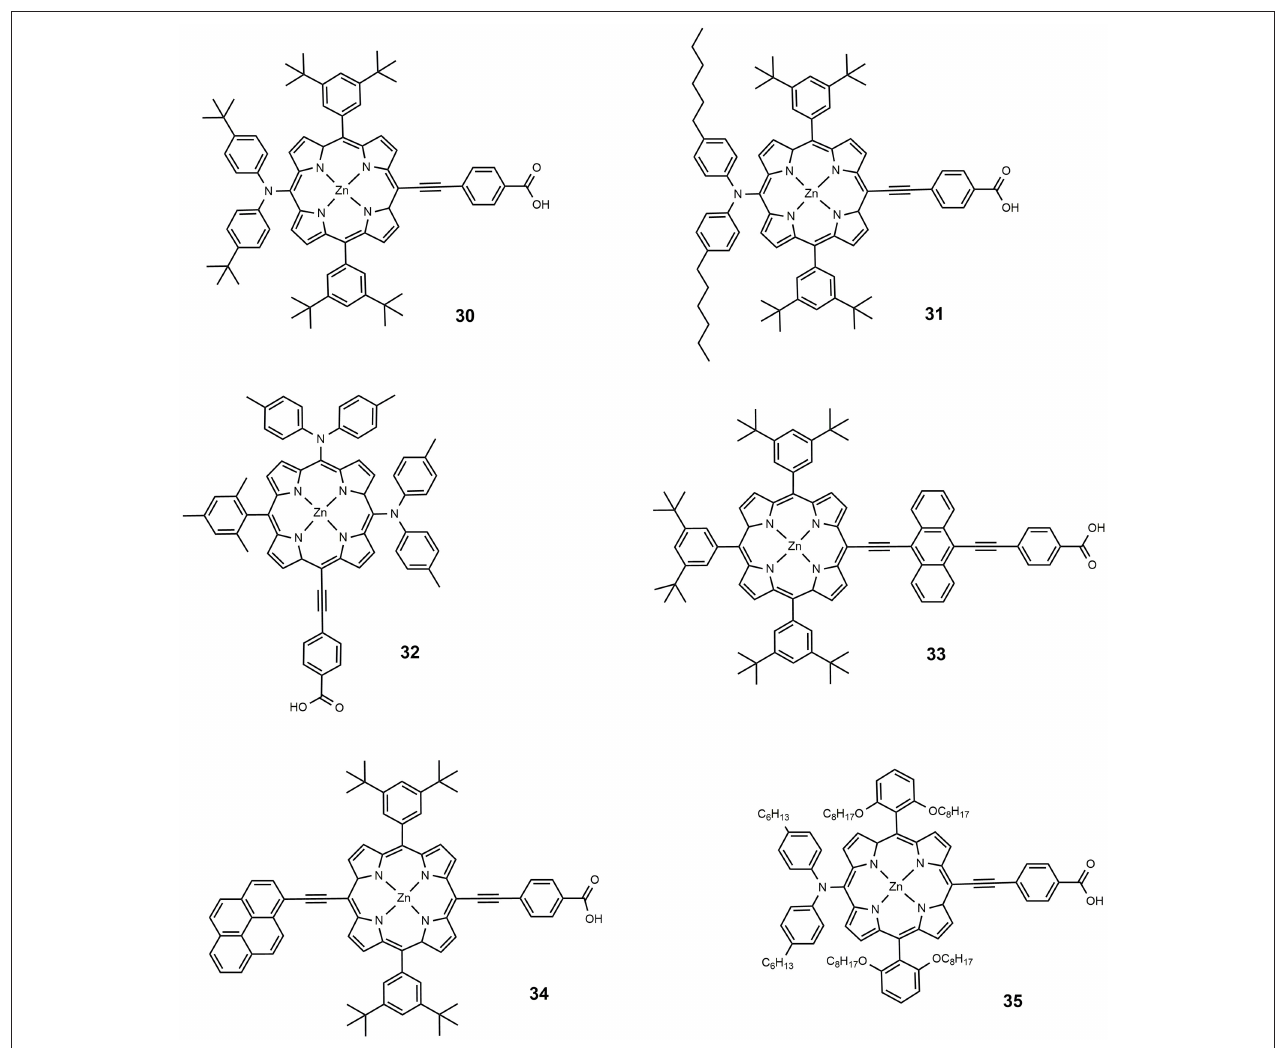
FIGURE 5 | Chemical structures of dyes